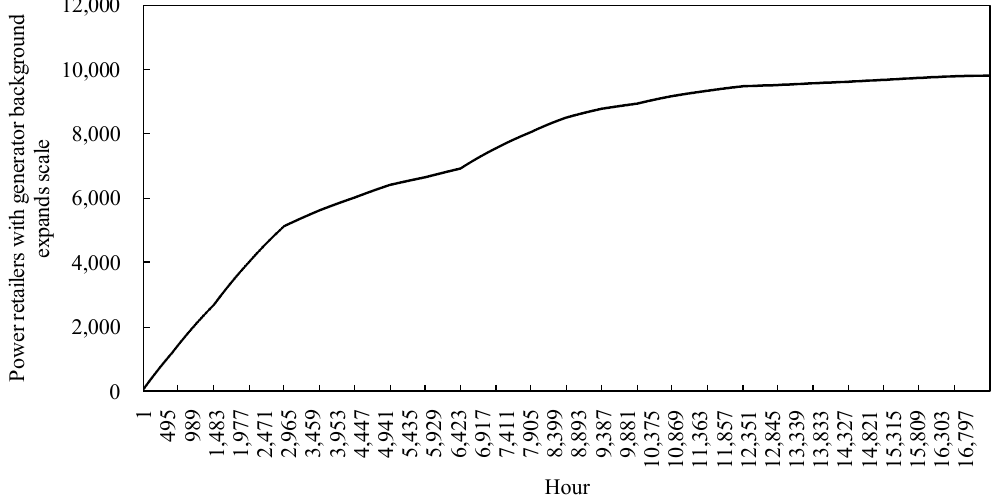
Figure 14. The expansion scale of power retailers.